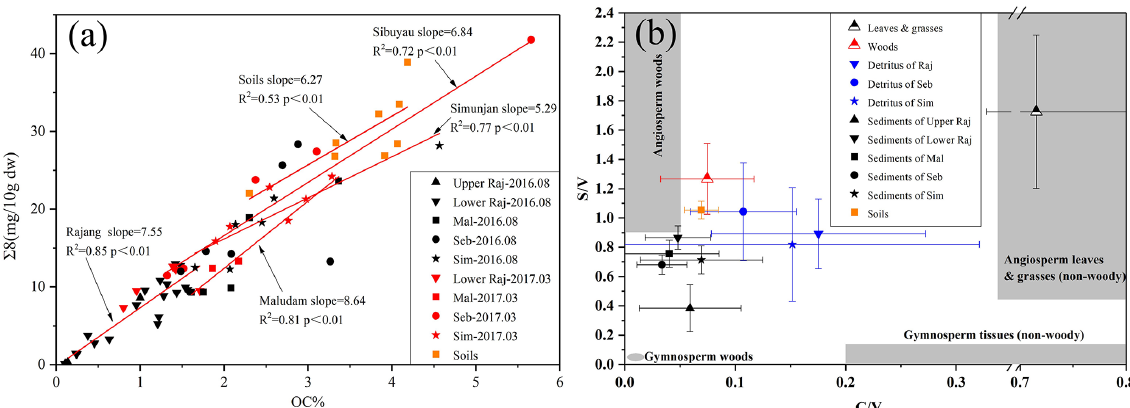
Figure 2. (a) Correlation of OC% with (cid:54) 8 among the various studied systems. (b) Variations in S / V versus C / V of different samples from the studied systems. Raj: Rajang; Seb: Sebuyau; Sim: Simunjan; Mal: